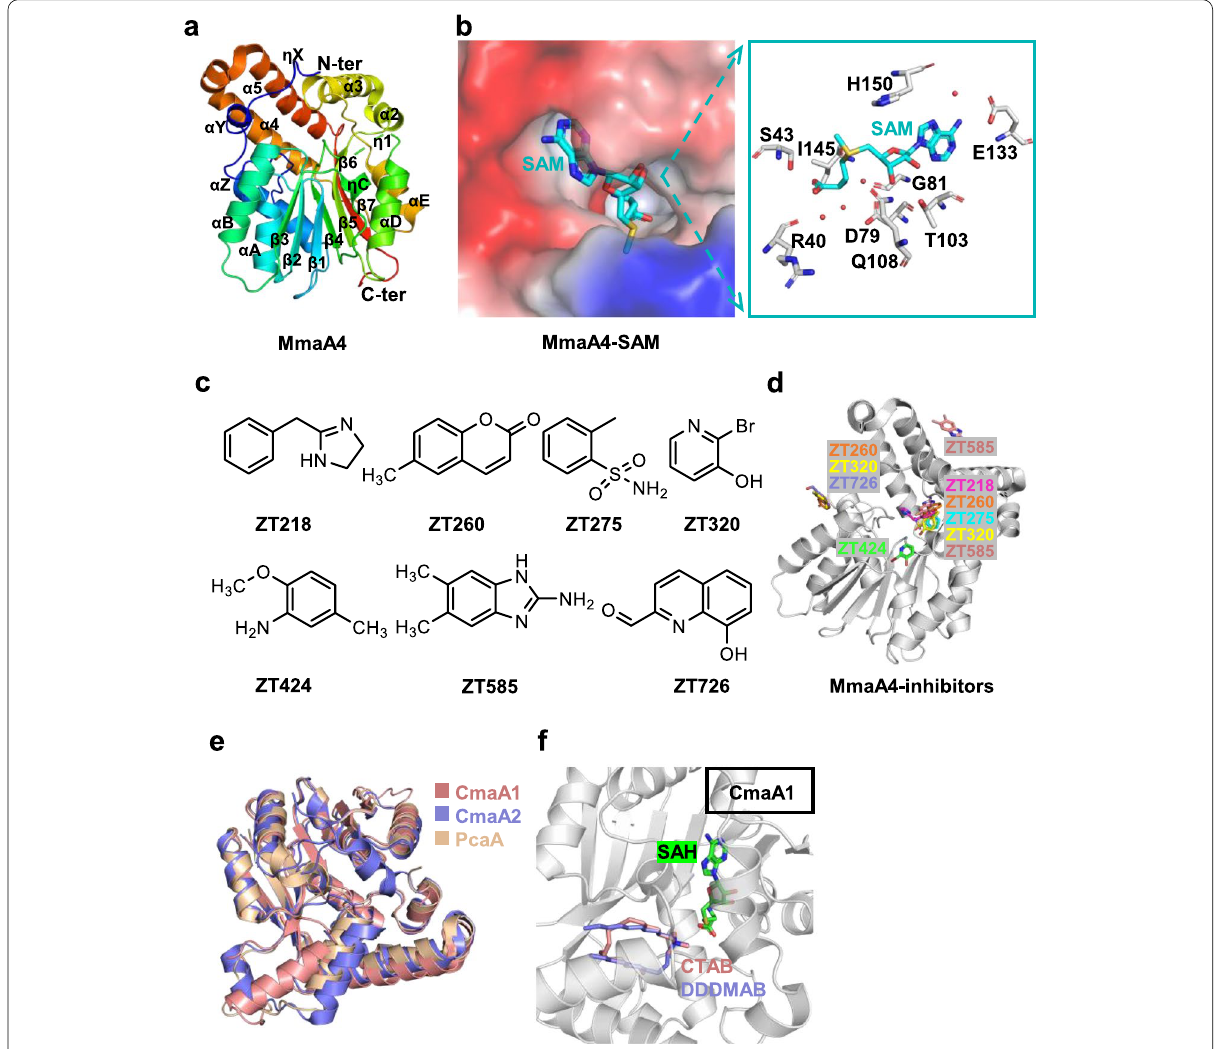
Fig. 3 Enzymes participating in the specific modification of mycolic acid. a Structure of MmaA4 (PDB ID: 2FK7). b Structure of MmaA4-SAM (PDB ID: 2FK8). The electrostatic potential was computed using the APBS tools in PyMol (http:// www. pymol. org/). c , d Structure of MmaA4-inhibitors (PDB ID: 7Q2B-H). e Superposition of CmaA1, CmaA2 and PcaA (PDB ID: 1KP9, 1KPI, 1L1E). f Structure of CmaA1-SAH-CTAB/DDDMAB (PDB ID: 1KPG,